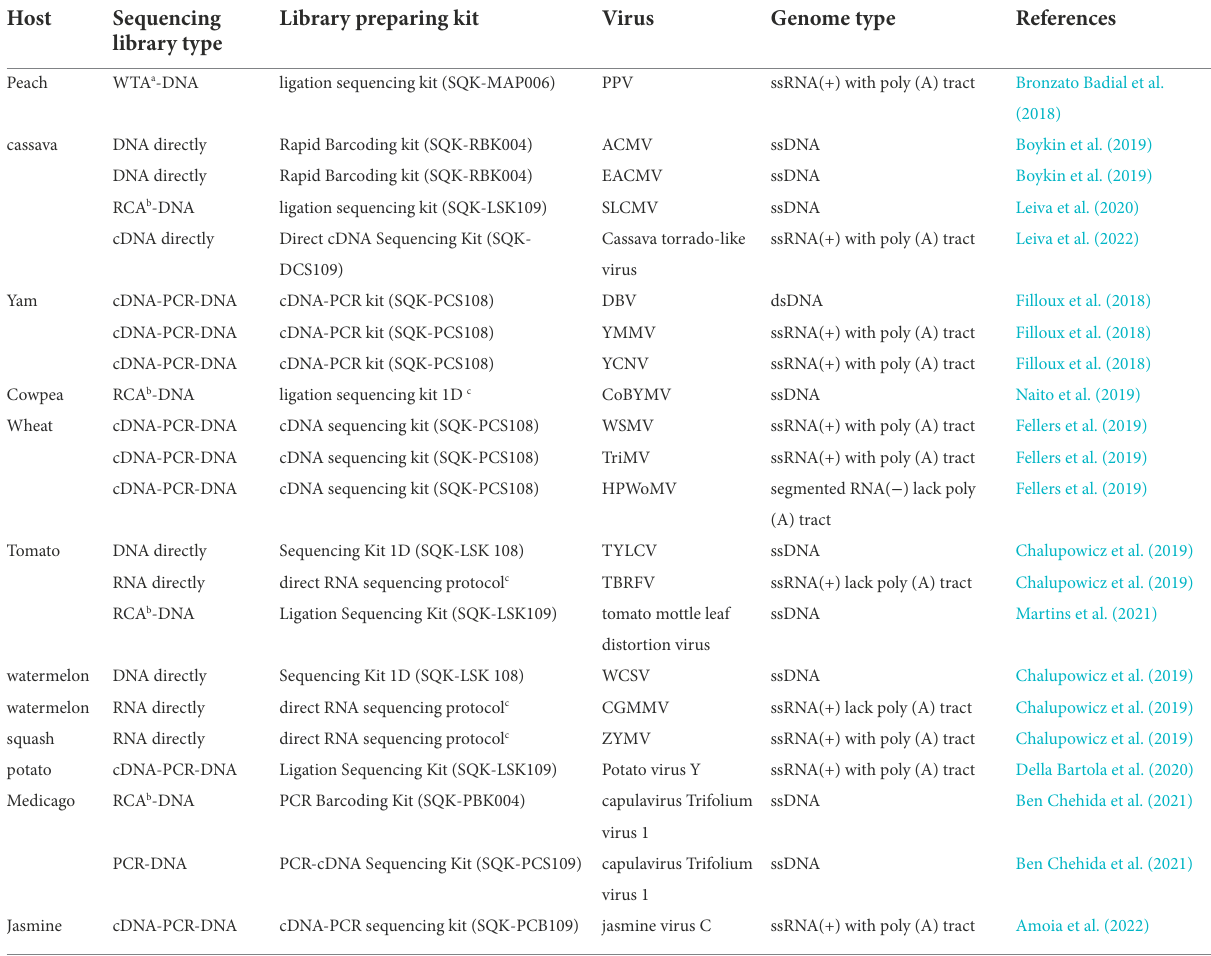
TABLE 3 Summery of viruses detected in plants using nanopore sequencing